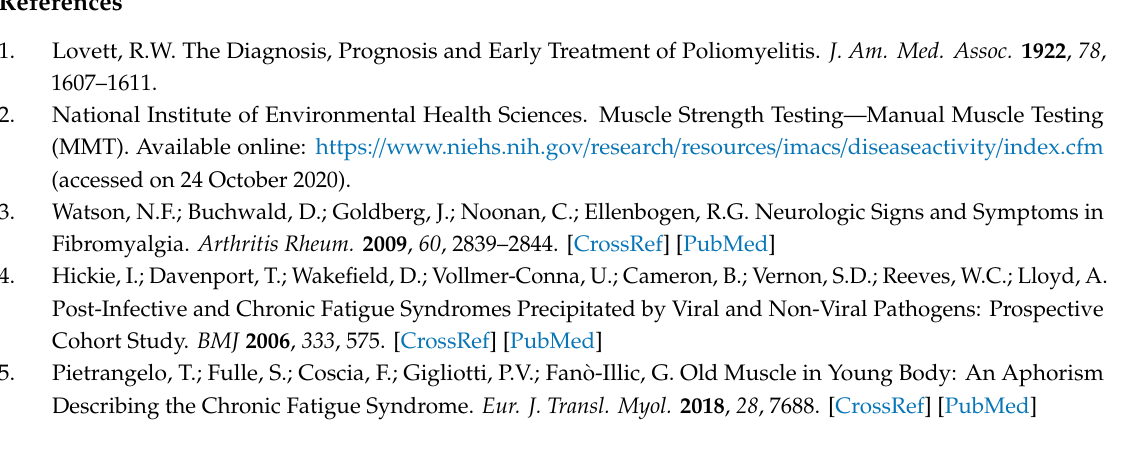
the linear section XYZ (slope_XYZ), Table S6: Intraclass correlation coe ffi cient and normalized mean Euclidean distance